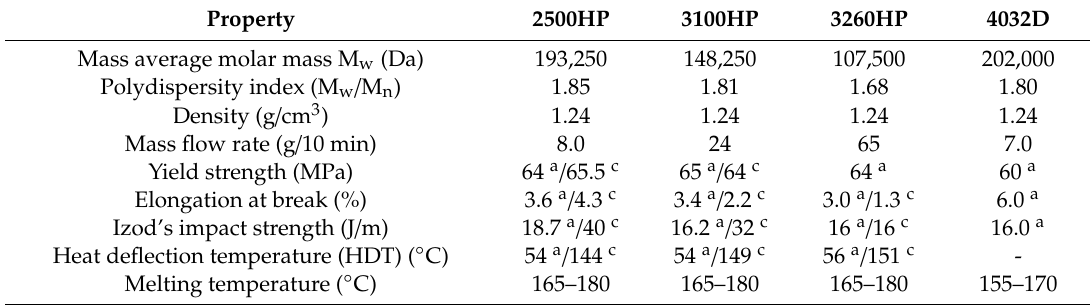
Table 1. Chosen properties of the studied polylactide (PLA) grades according to the technical datasheets.